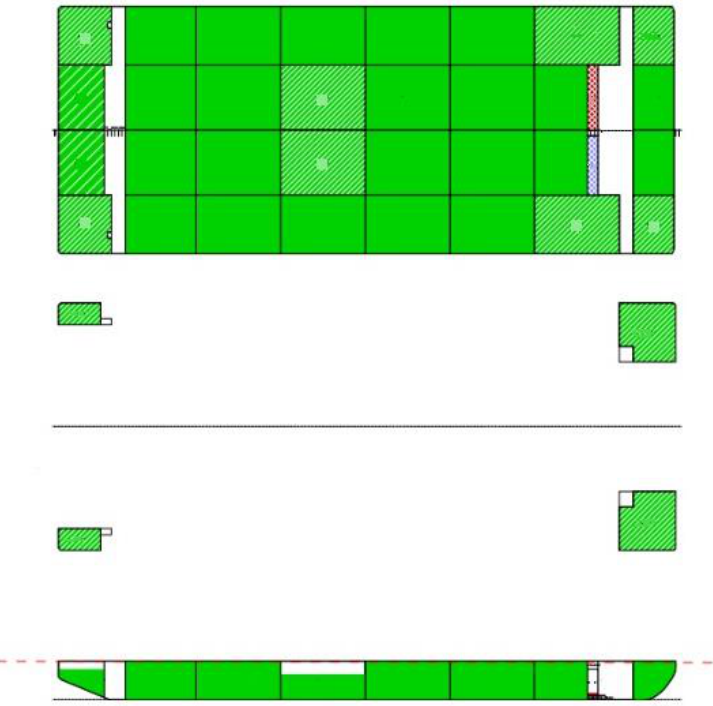
Figure 17. Schematic diagram of LCS2 ballast water distribution.